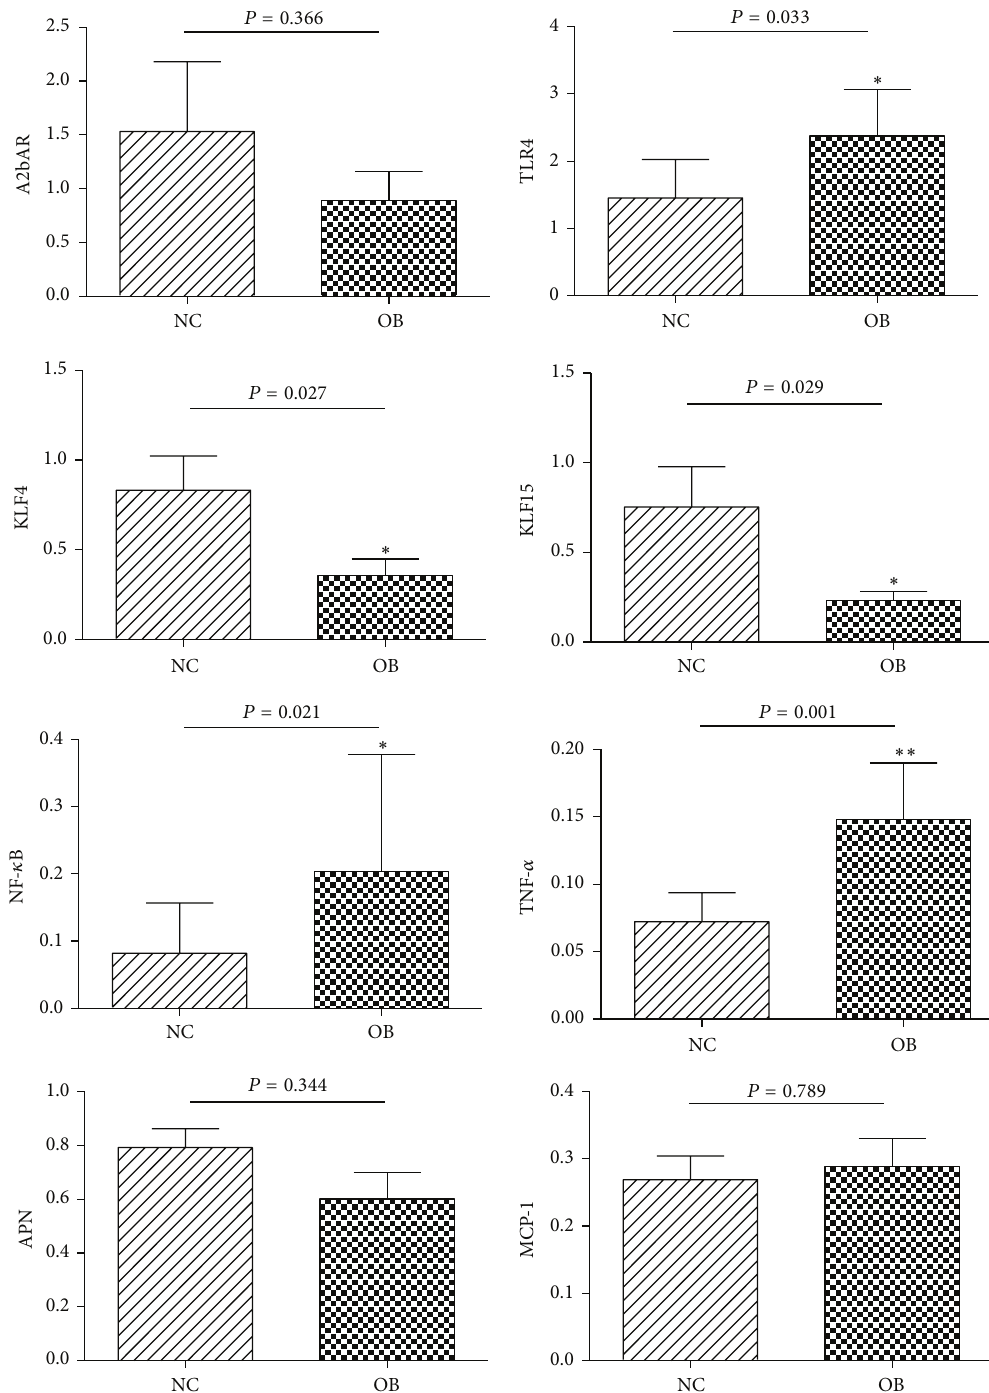
Figure 1: The mRNA expression level of critical gene in inflammation signaling pathways. 𝑡 -test, ∗ 𝑃 < 0.05 , ∗∗ 𝑃 < 0.01 . The difference between the two groups has statistical